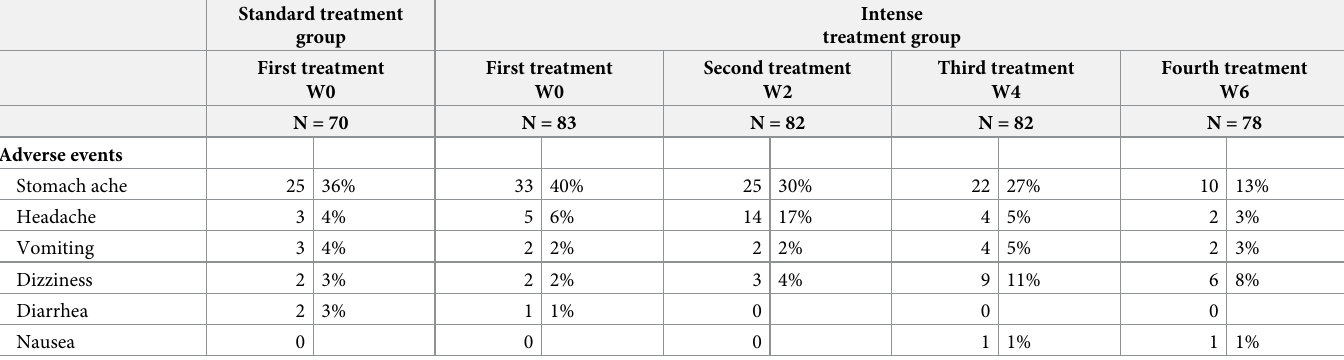
Table 3. Main type of adverse events observed and reported 3 hours after PZQ administration in S . mansoni -infected children in the standard treatment group and the intense treatment